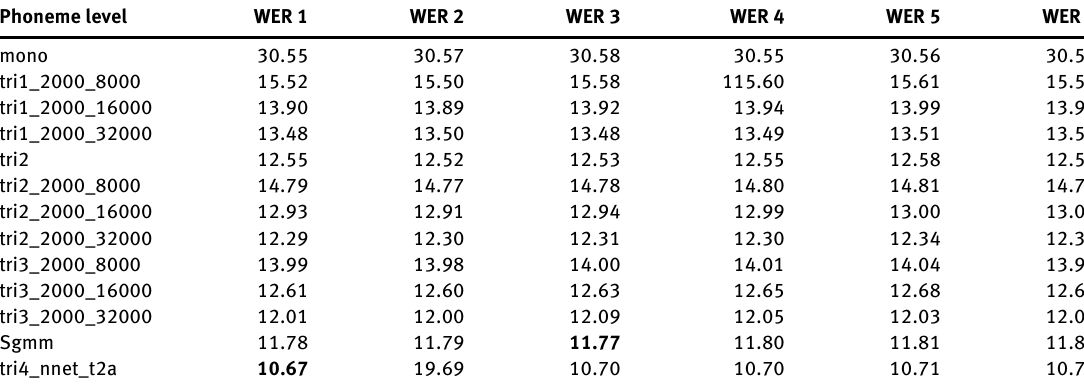
Table 19: The Description of WERs at Different Phoneme Levels for Overall Enhanced Speech Data, Which Includes Districts, Mandis, and